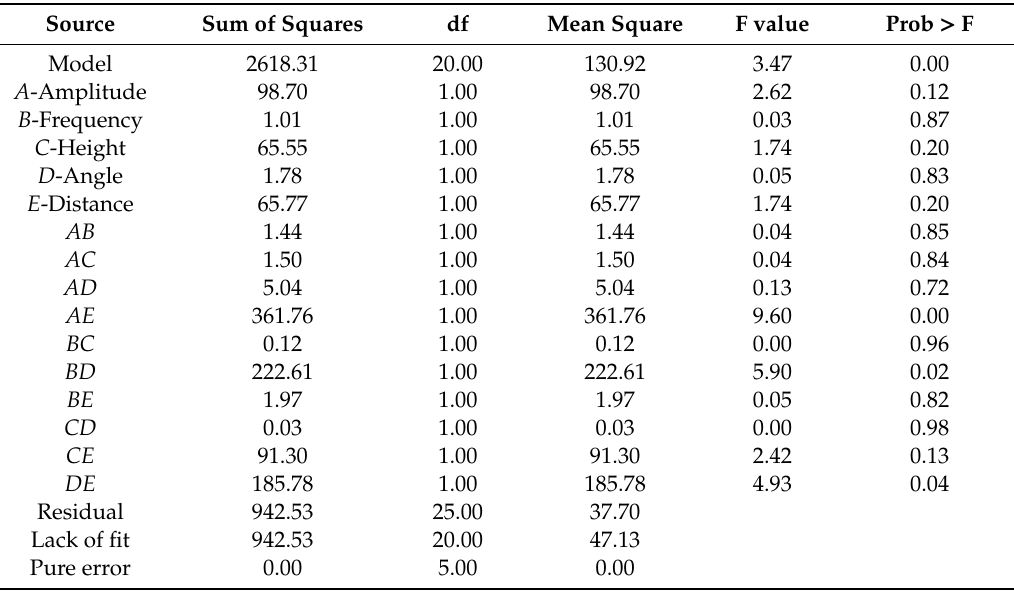
Table 8. Variance analysis of quadratic